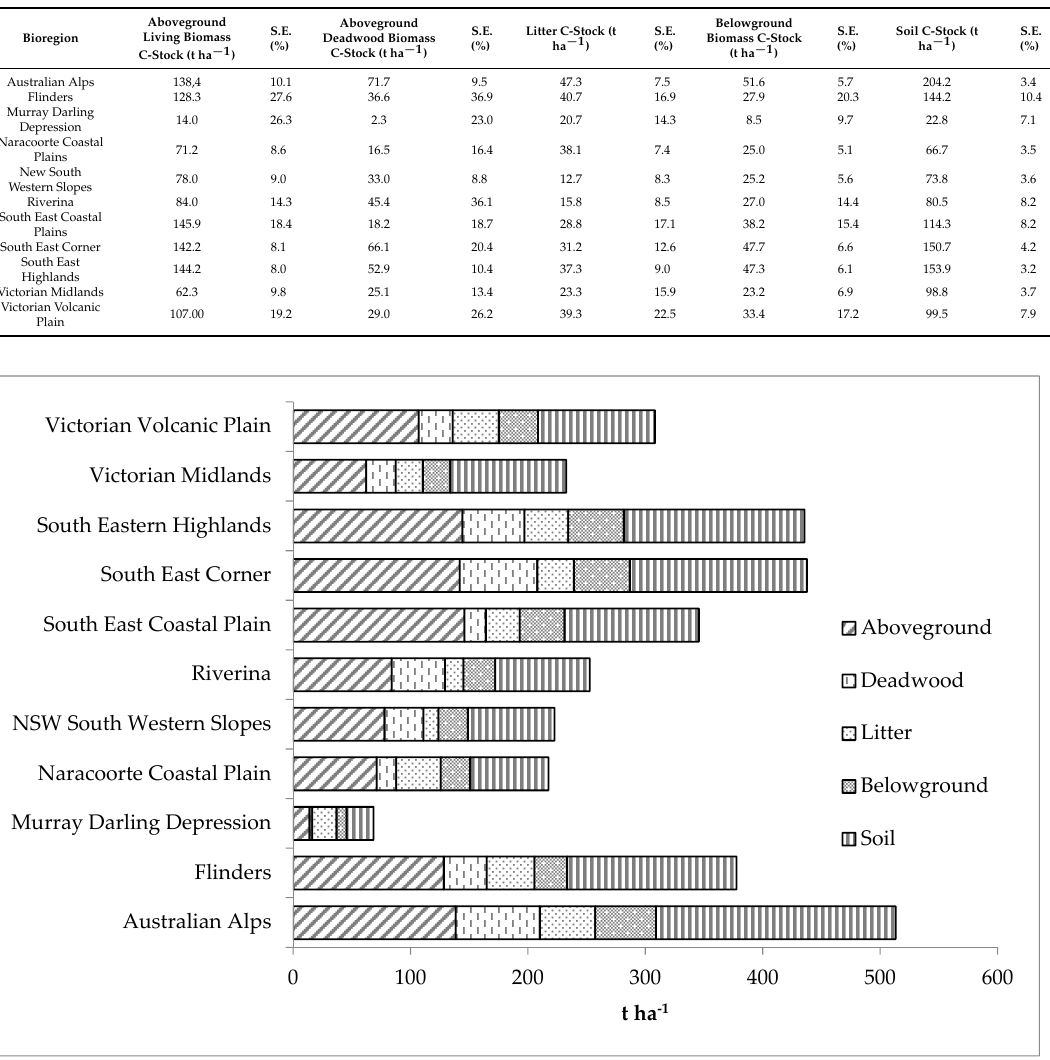
Table 4. Public land forest area within altitude classes (in metres above sea level (m a.s.l.)) and estimated C ‐ stock per hectare (with standard errors) for different carbon pools. Altitude Class (m a.s.l.)